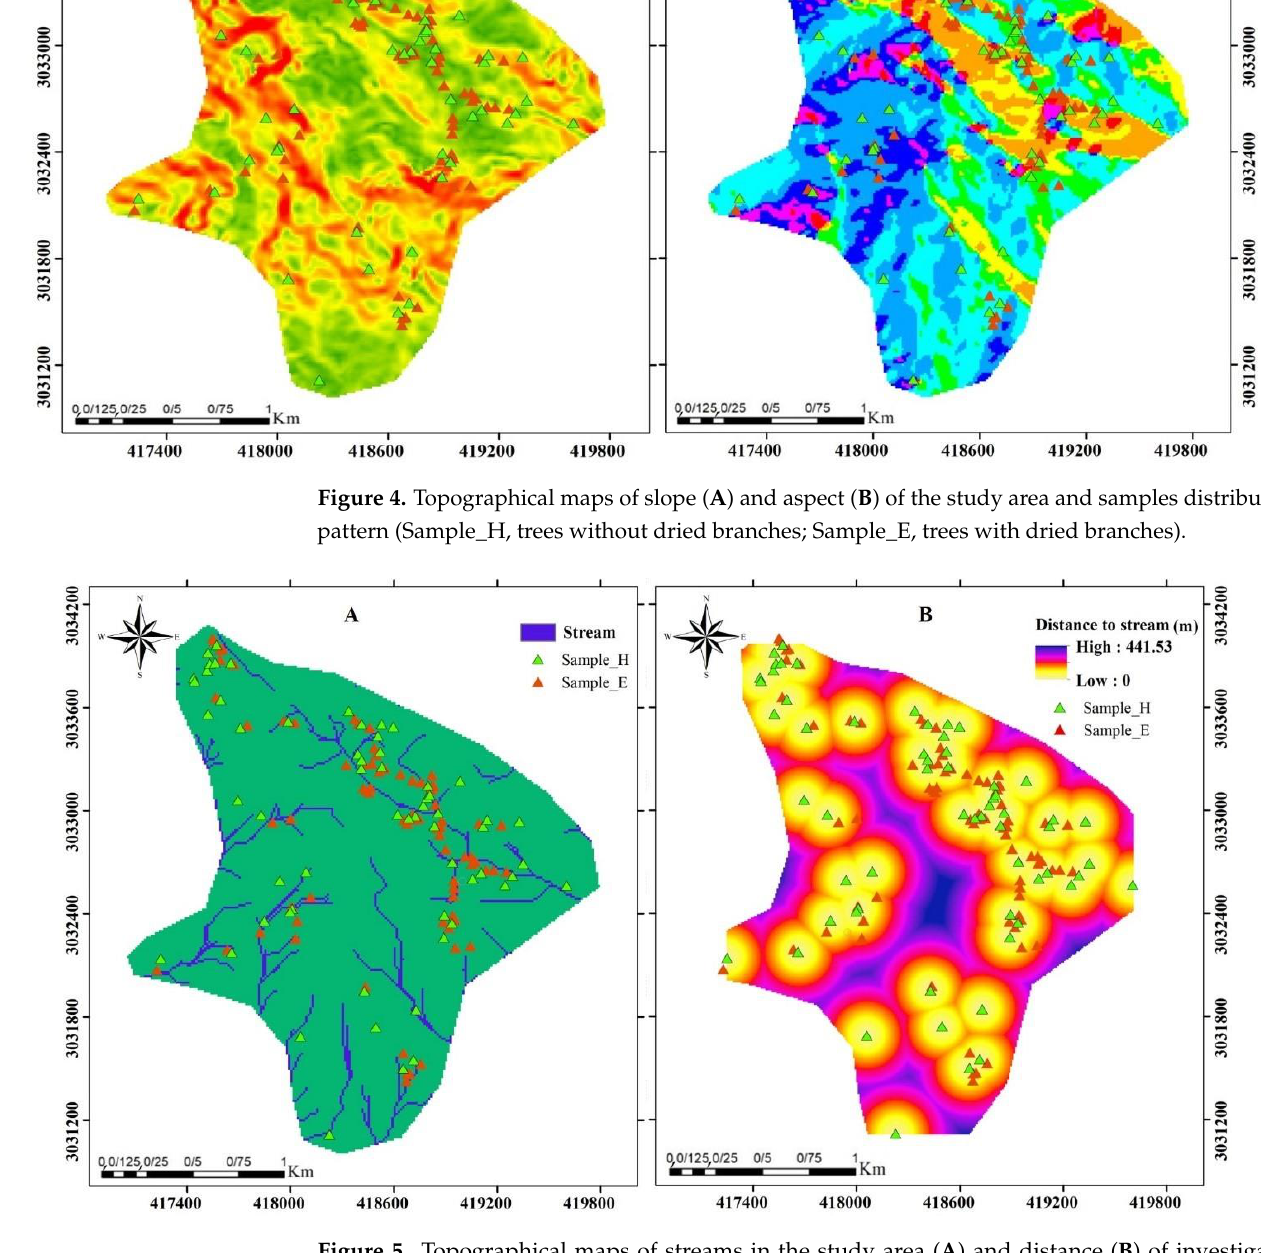
Figure 5. Topographical maps of streams in the study area ( A ) and distance ( B ) of investigated samples to stream (Sample_H, trees without dried branches; Sample_E, trees with dried branches).